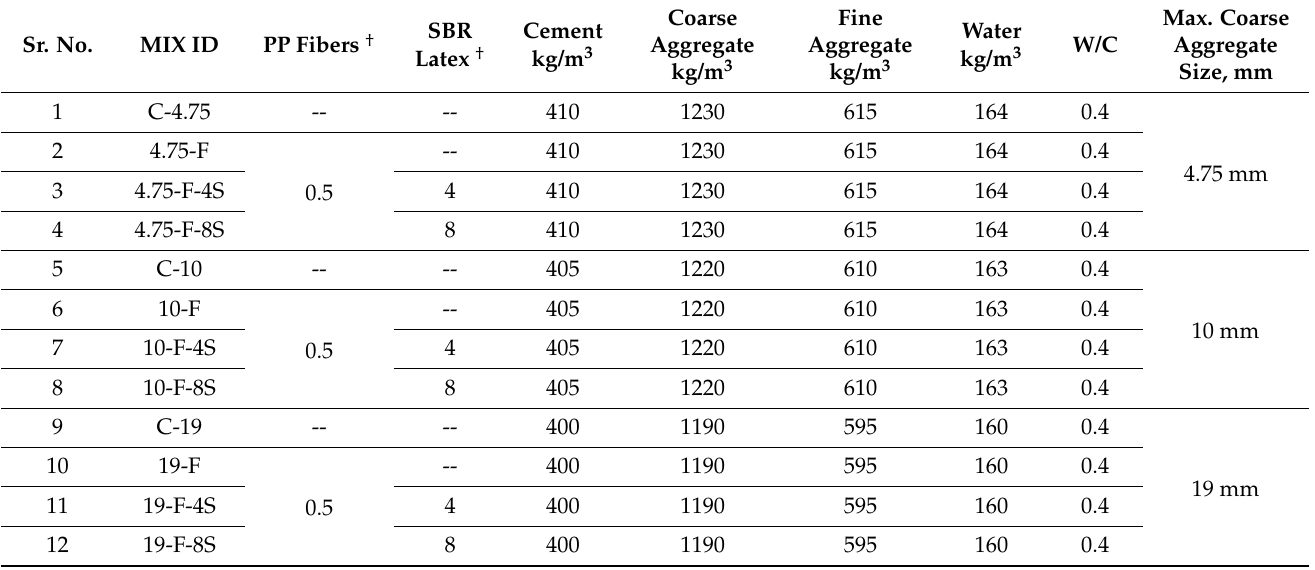
Table 4. Details of the mix design.